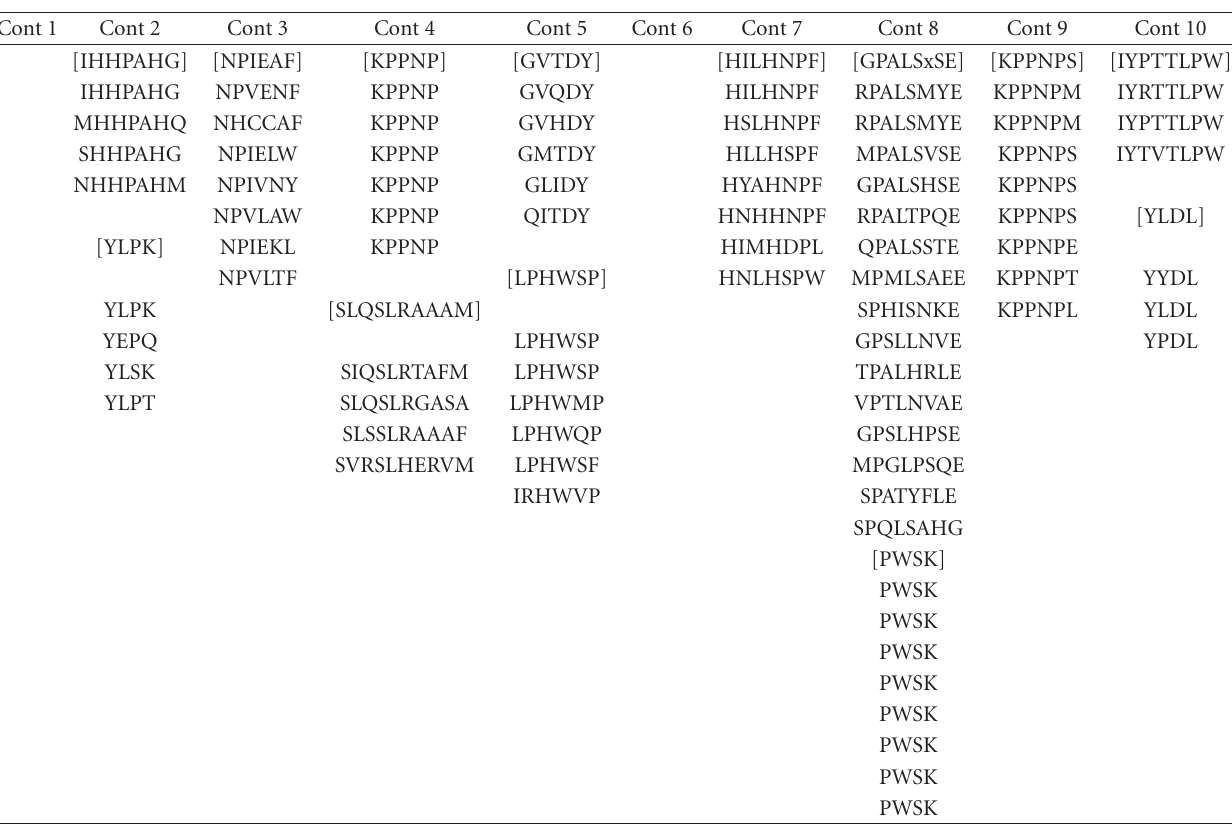
Table 2: Common peptide motifs in control group.